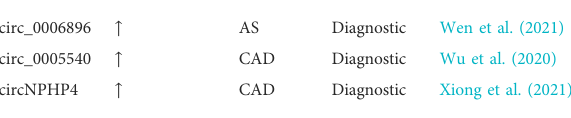
TABLE 1 The biomarkers of serum/plasma exosomal circRNAs in cardiovascular diseases. CircRNA Expression Disease Function References